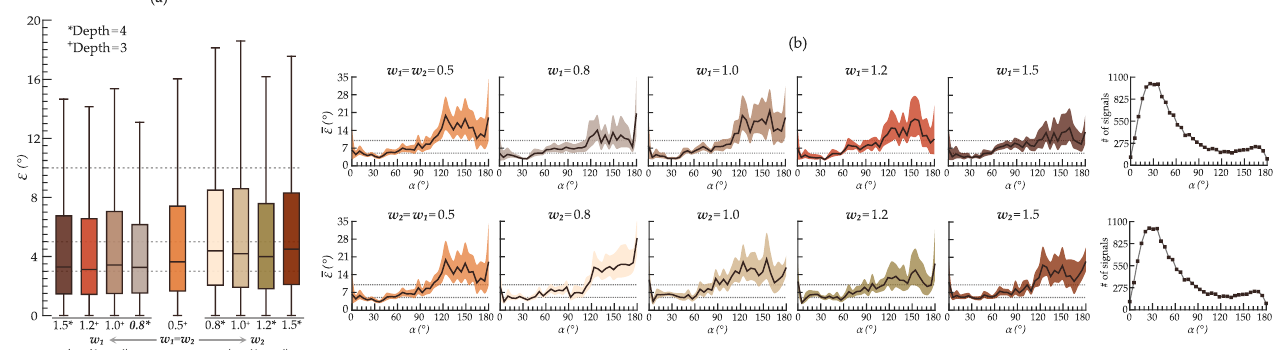
Figure 7. Performance of various model configurations tuned with different combinations of hyper- parameters w 1 and w 2 in estimating the spatial QRS-T angle from leads XYZ in the validation dataset. ( a ) Boxplot of the obtained absolute error (cid:101) (outliers not shown) for every combination of w 1 and w 2 . w 1 increases to the left side, wheres w 2 to the right. The other hyperparameter value is obtained as | 1 − w | on each side. ( b ) Mean absolute error (cid:101) and the respective 95% confidence interval across the ranges of α =[0:5:180] ◦ for increasing w 1 ( top row ) and w 2 ( bottom row ). The last column displays the number of training samples for each range of α .